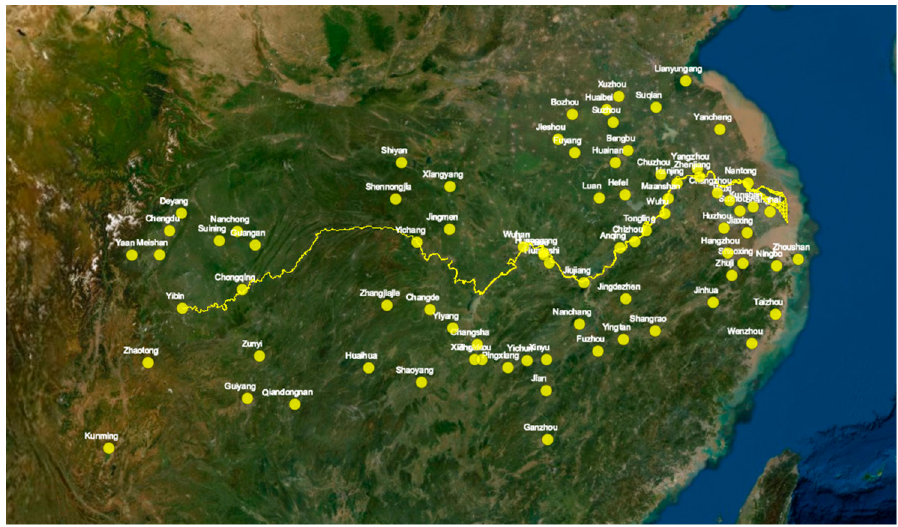
Figure 3. Distribution of cities mentioned in the news. Data source: Google Earth.